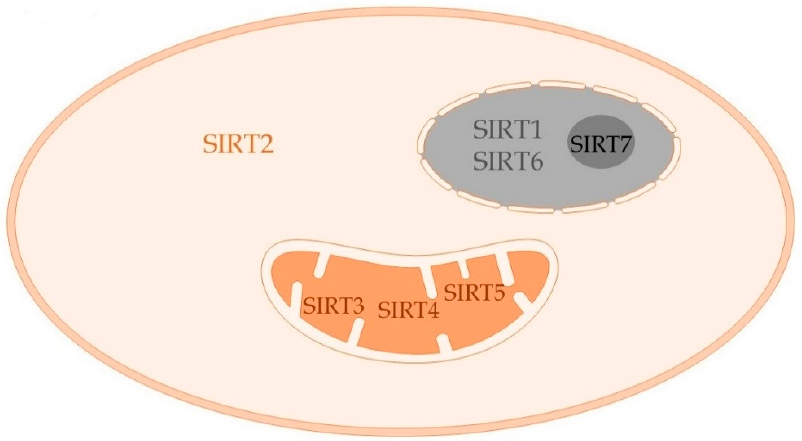
Figure 3. Sirtuin expression in immune cells: The seven sirtuins SIRT1–7, the NAD+ sensors, are dispersed throughout subcellular compartments of cells. SIRT1 and SIRT6 are nuclear, SIRT7 is nucleolar, and SIRT3, SIRT4 and SIRT5 are localized in mitochondria, while SIRT2 is predominantly cytosolic. Each of these sirtuins have their own unique targets that define their biological activity as described in the text.